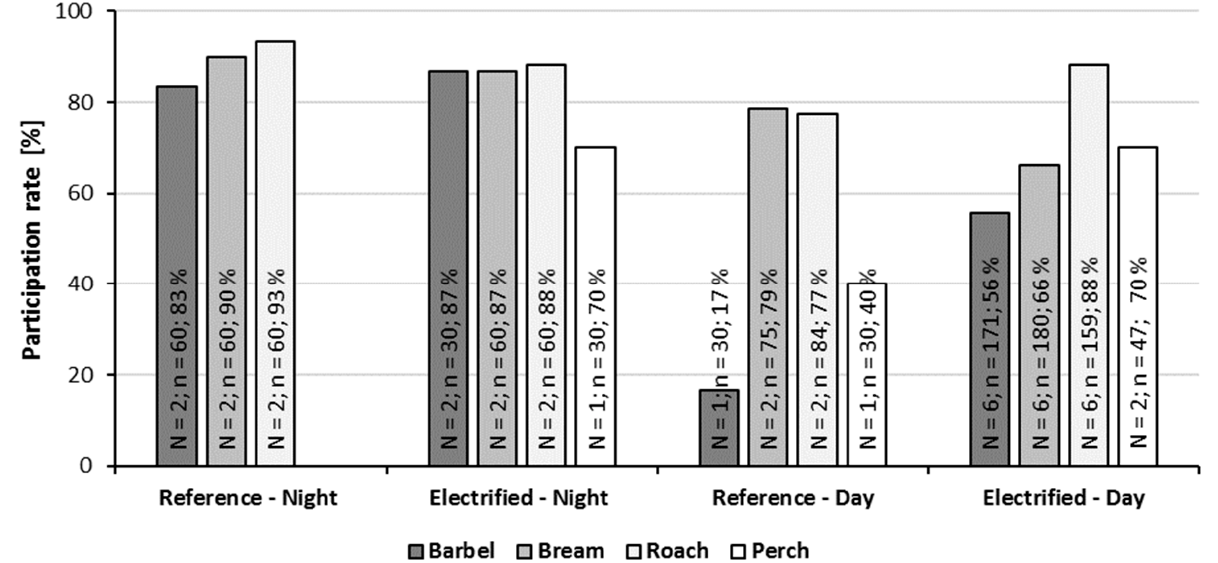
Figure 3. Species-specific participation rate during the first four hours of trials [%] for reference and treatment conditions in night-time and day-time trials separately for barbel, bream, roach and perch. N denotes the number of conducted trials with the considered species in the setup, n the number of stocked fish per treatment condition and species.